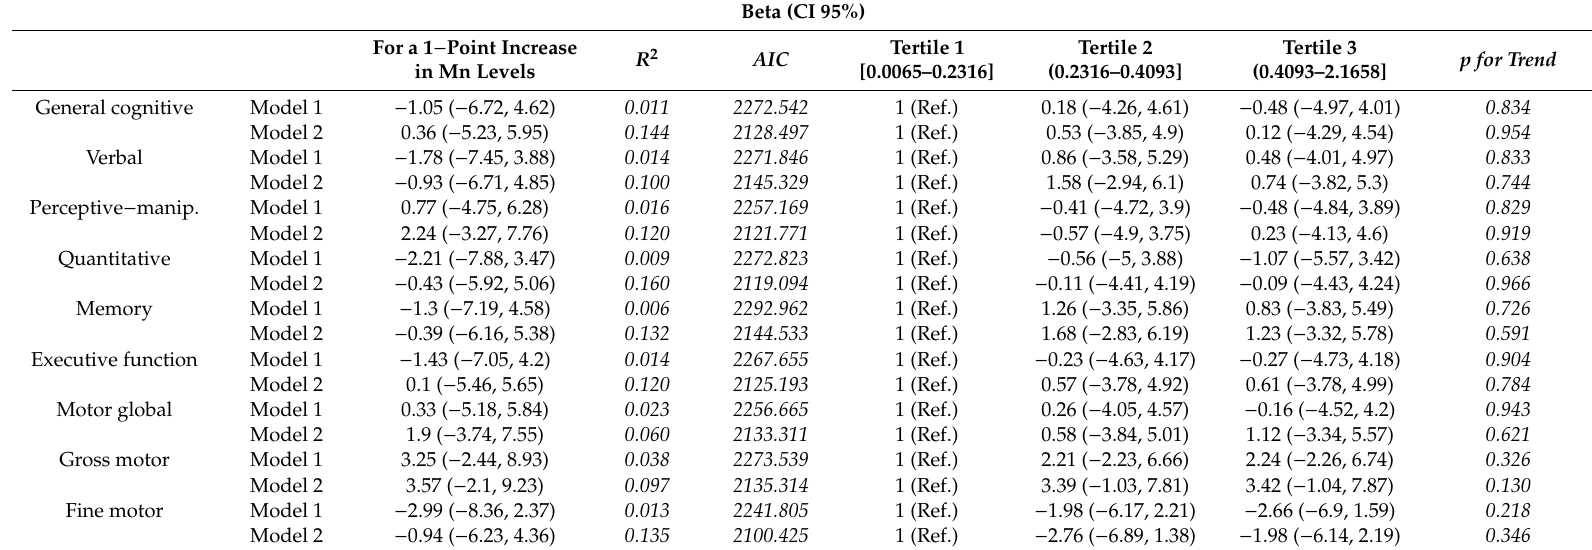
Table 2. Linear regression models for the association between Mn and the McCarthy scale scores. Change in McCarthy scale scorefor1 µ g / g increase in Mn and by tertiles of the Mn